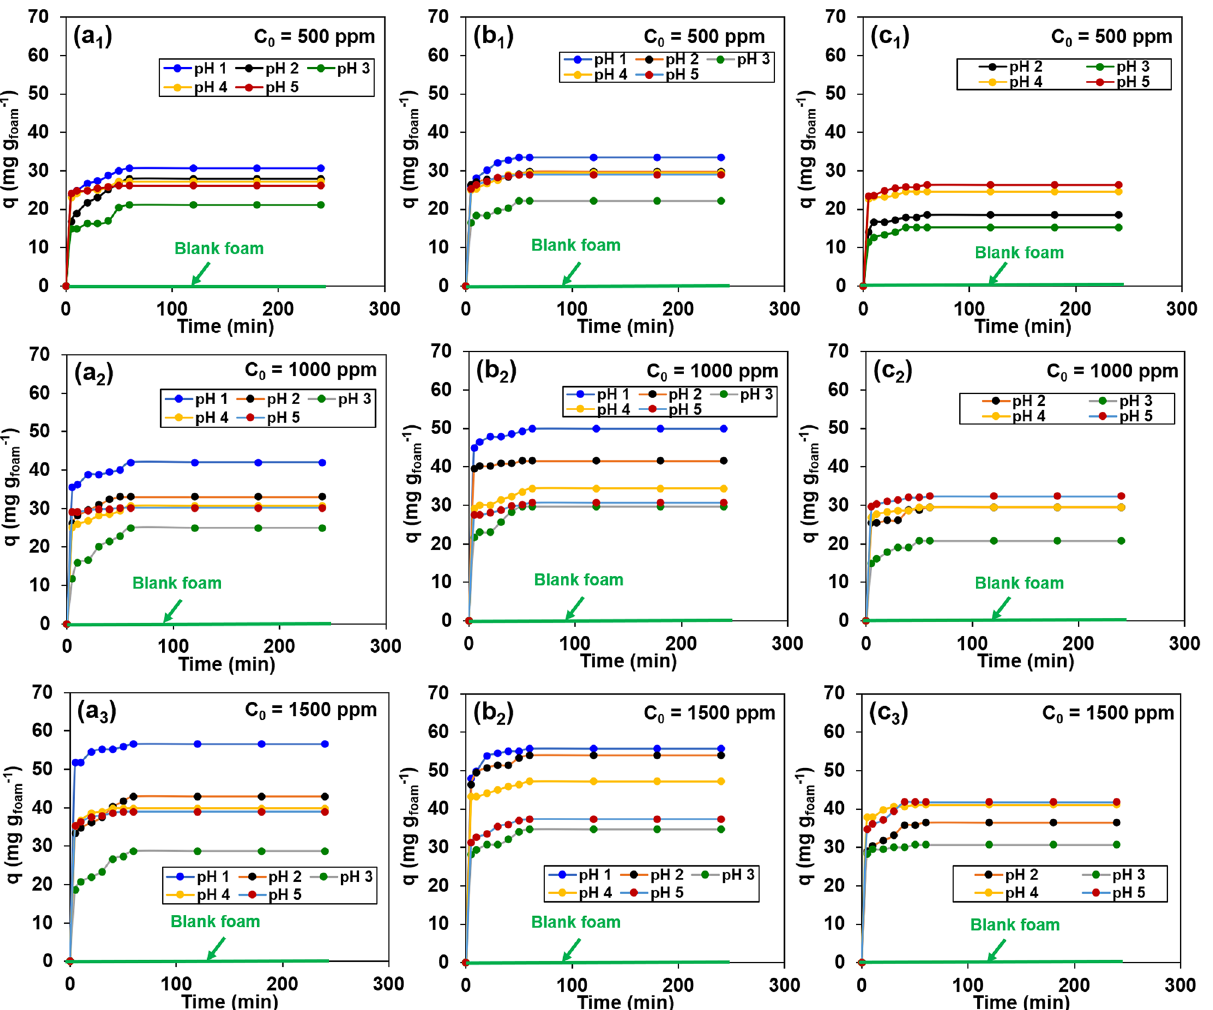
Figure 4. Effects of contact time, pH, and initial concentration on the functionalised carbon foam adsorption of Cu(II): ( a 1 –a 3 ) C-SO 3 H; (b 1 –b 3 ) C-COOH; (c 1 –c 3 ) C-NH 2 , and green line (—) for the blank foam (polyisoprene foam without functionalised